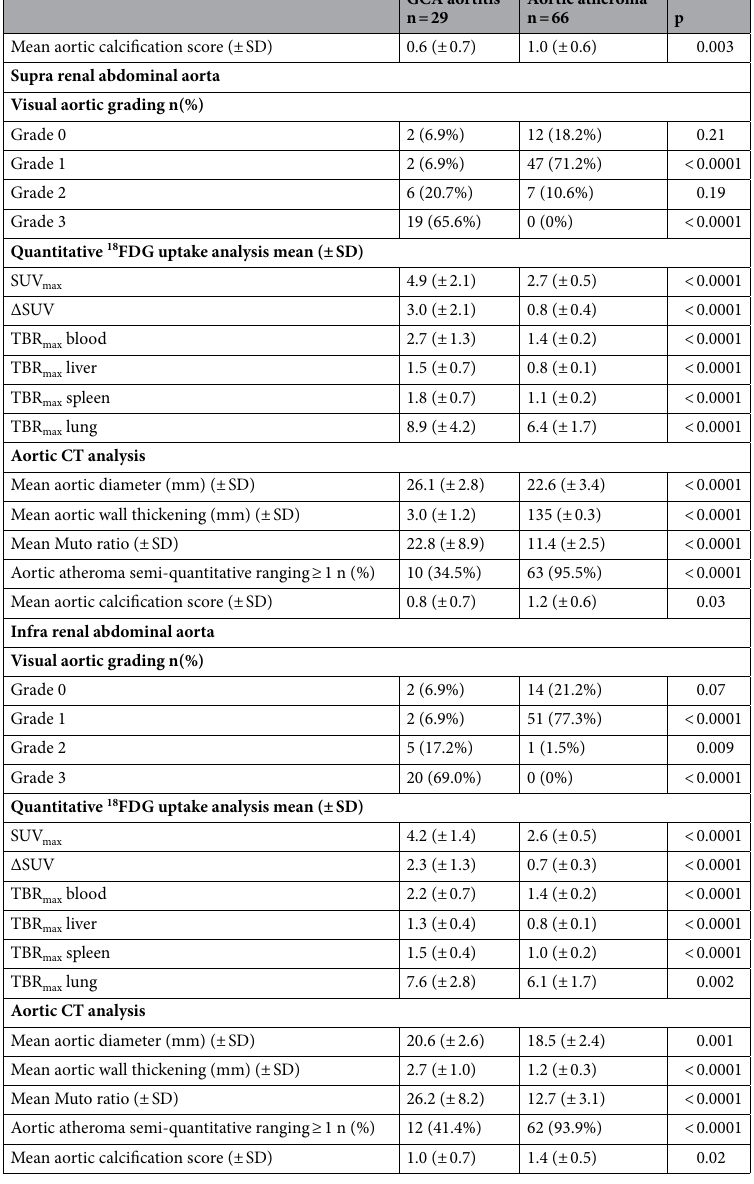
Table 2. Comparison of FDG-PET/CT and CTA features in each group by aortic segment. SUV standardized uptake value, TBR target to background ratio, ∆SUV delta standardized uptake